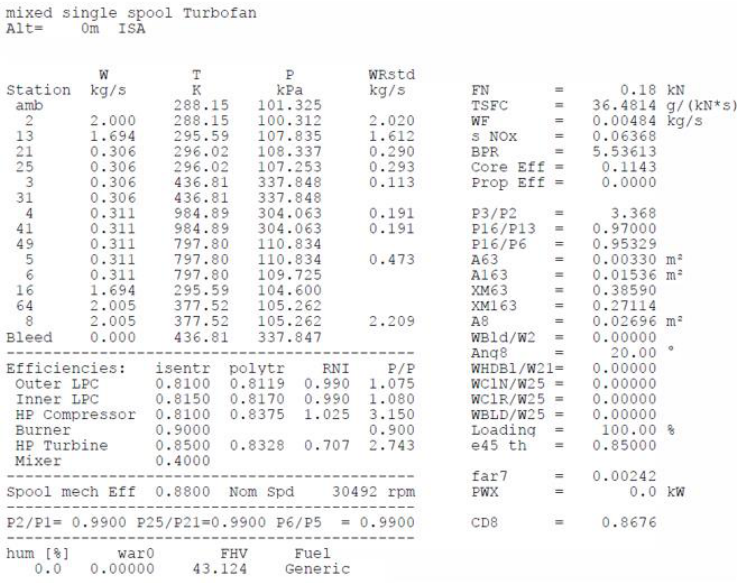
Figure A4. GasTurb simulation results for the fan speed 30,492 RPM.